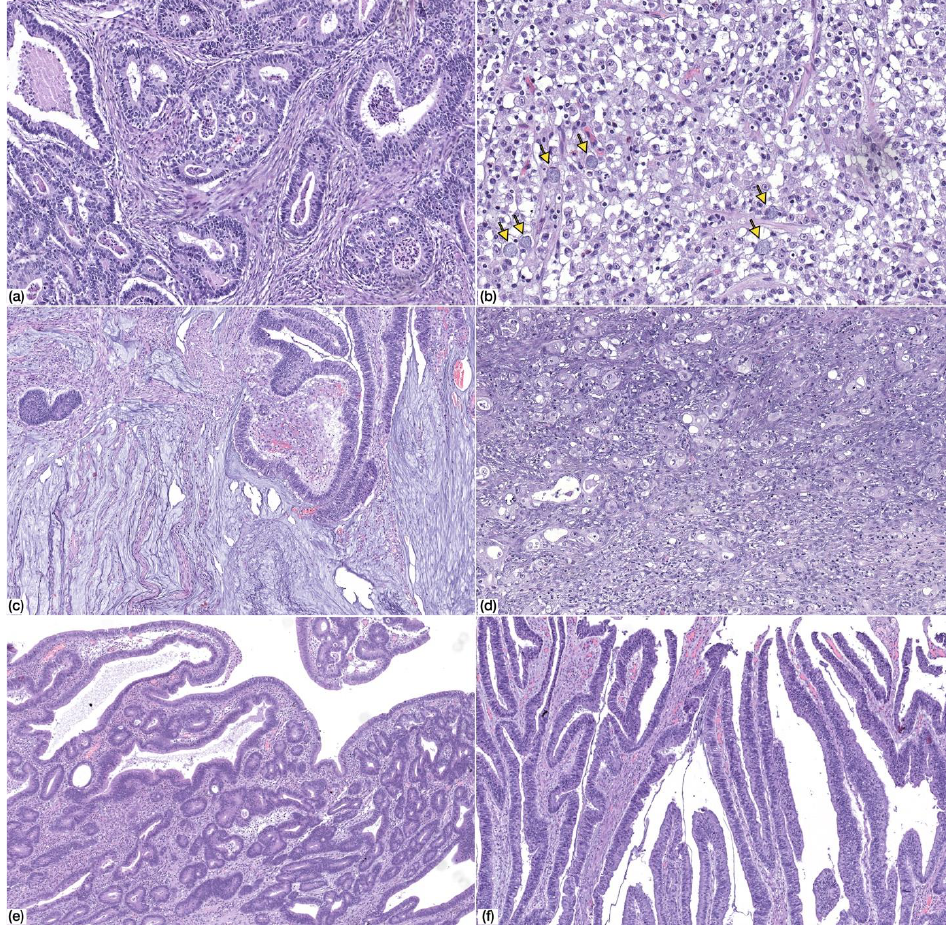
Figure 2. Morphology of common variable immunodeficiency (CVID)-associated gastric cancer. ( a ) Tubular gastric cancer, low-grade (HE, 100× magnification); ( b ) tubular gastric cancer, high-grade (HE, 100× magnification); ( c ) mucinous adenocarcinoma (HE, 50× magnification); ( d ) poorly-cohesive carcinoma, PCC-NOS (HE, 200× magnification). Note the presence of scattered signet ring cells (arrows); ( e, f ) adenomatous lesion, low-grade dysplasia, with tubular ( e ) and villous ( f ) architecture (HE, 50× magnification).